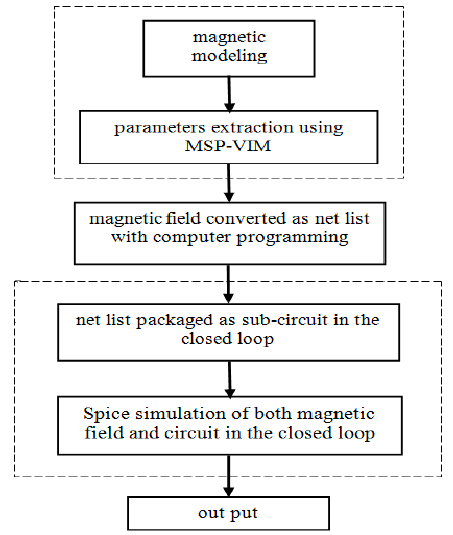
Figure 2. The flow chart of the proposed method.